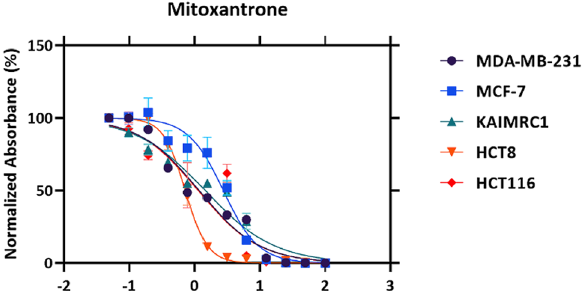
Figure 9. The dose–response manner and the inhibition curve of the positive control (Mitoxantrone ) on different breast and colorectal carcinoma